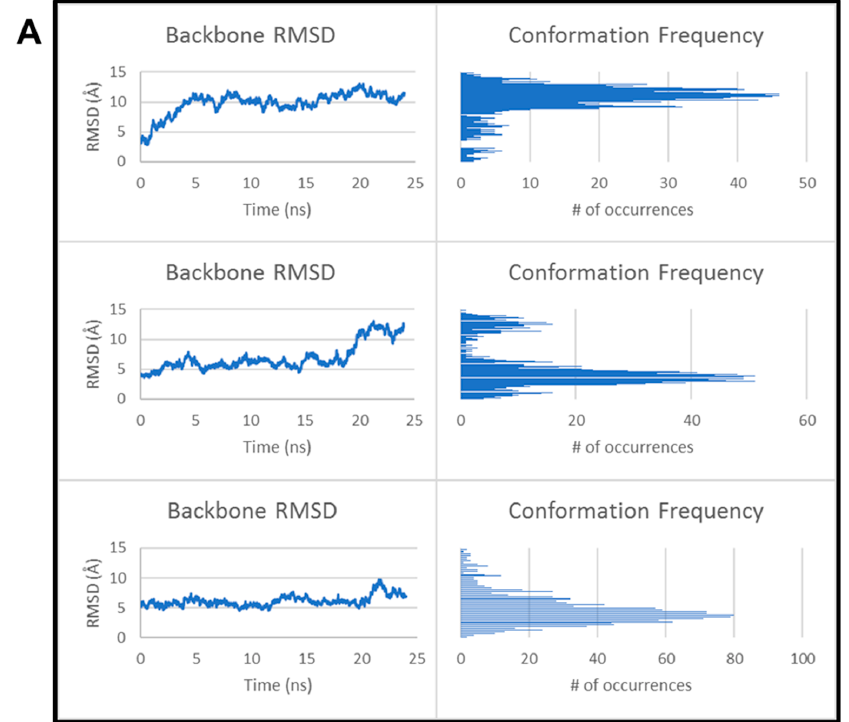
Table 1. Calculation of the binding energies (BE) (Kcal/M) of the CCAR1/H2AX model interactions using MM-PBSA and